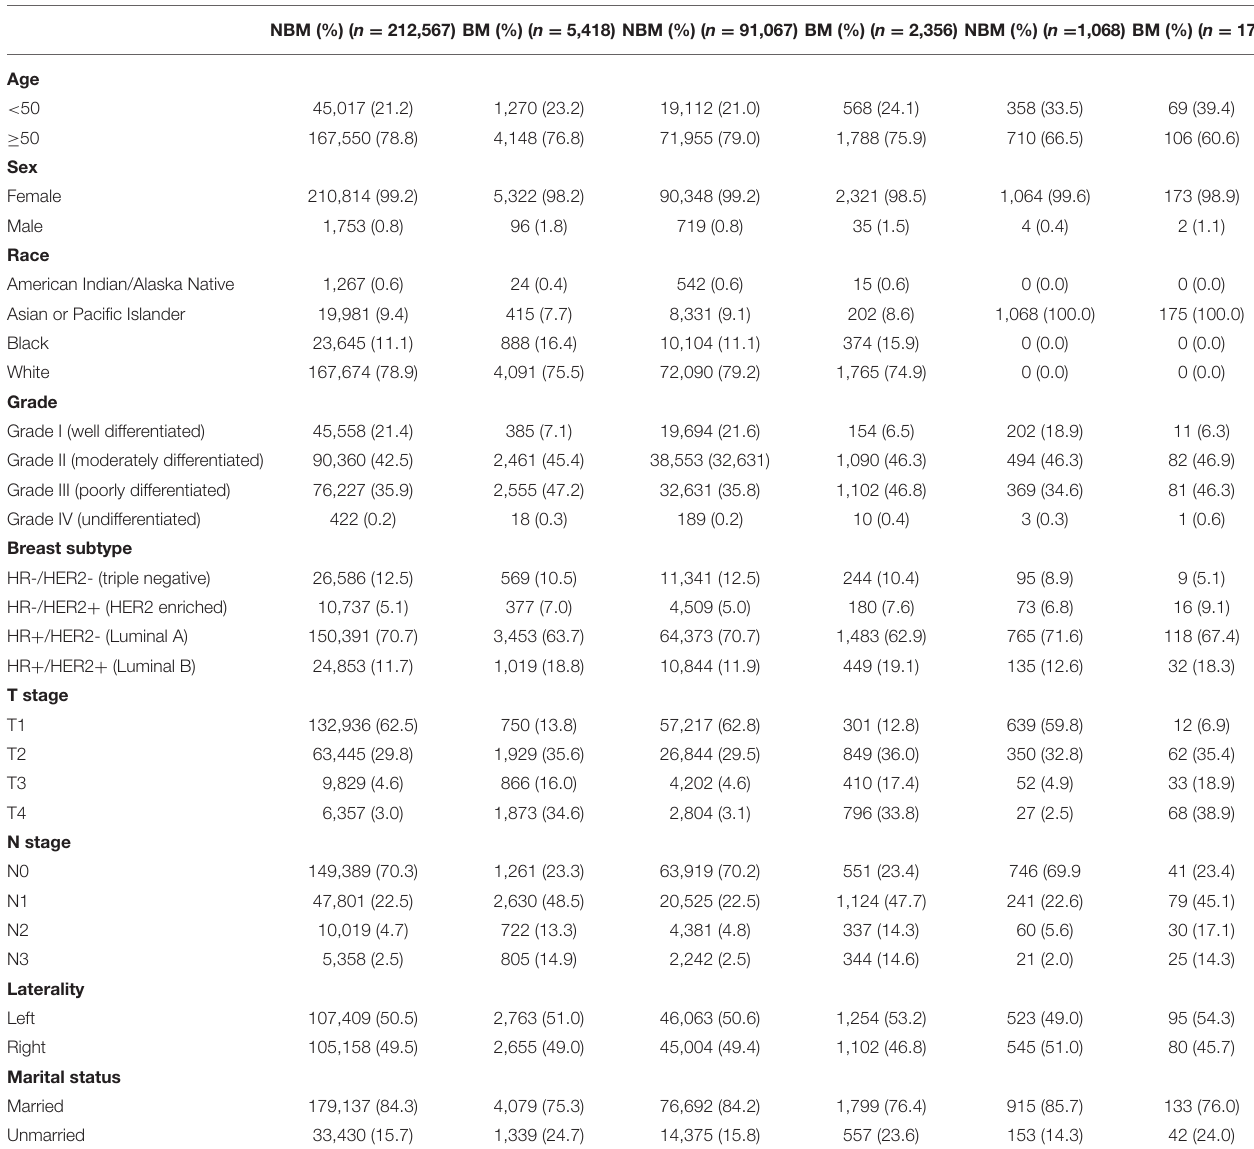
TABLE 2 | Clinical and pathological characteristics of training set and test set.